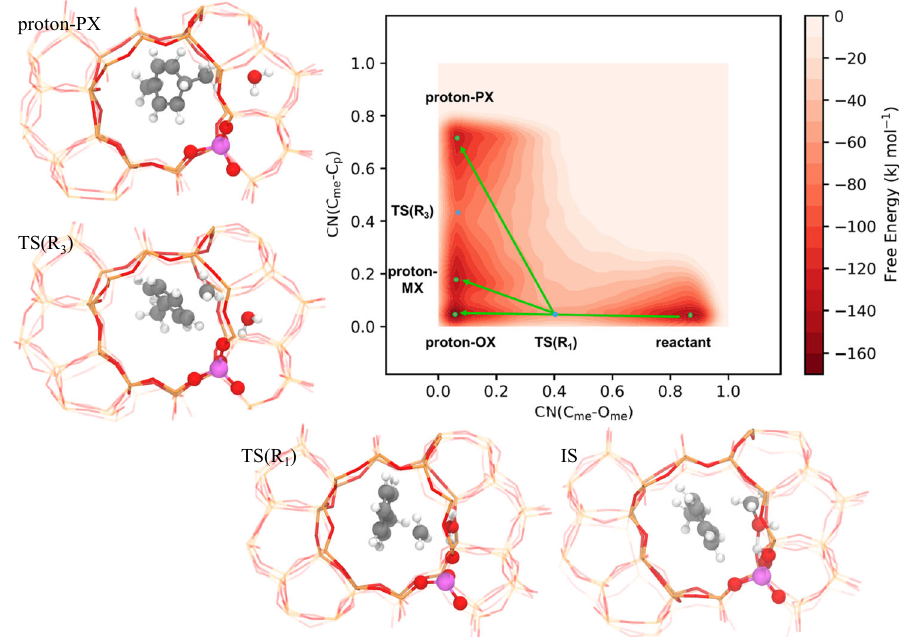
Fig. 3 Two-dimensional free energy pro fi le of the methylation of toluene. The pro fi le was obtained from metadynamics simulations. The selected conformations in this process are also presented. (Color code: gray, C; red, O; white, H; orange, Si; and pink,